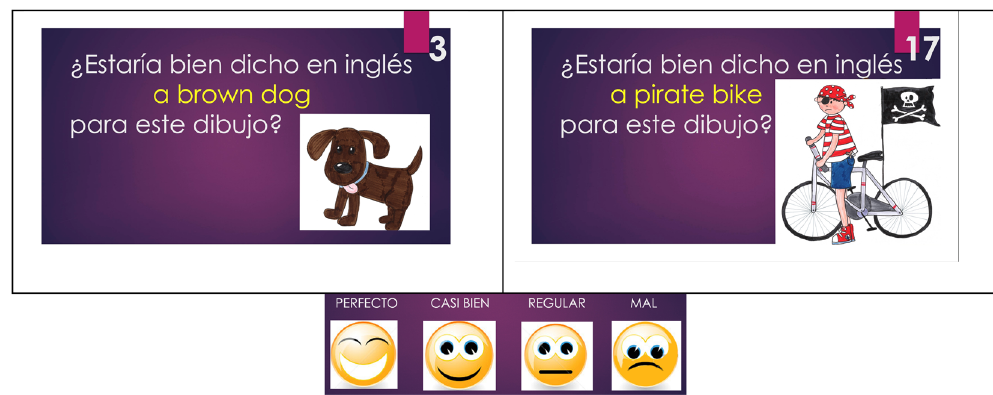
Figure 1: Grammatical experimental items: AN string and NN compound.